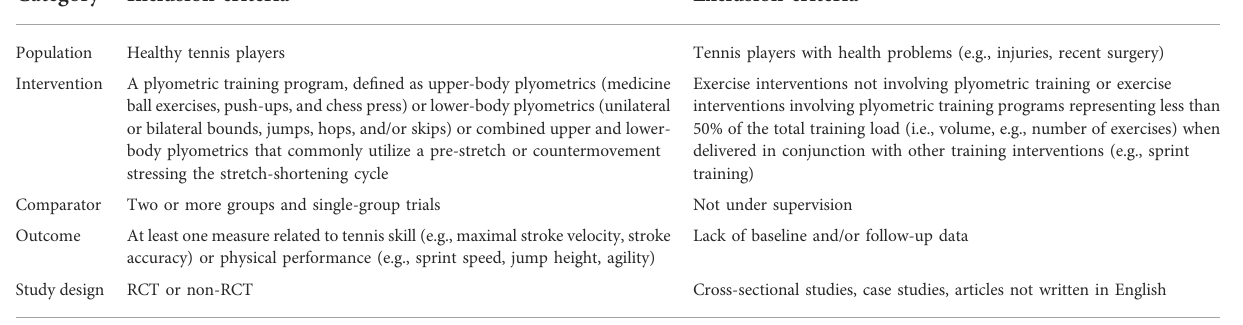
TABLE 1 Eligibility criteria according to the PICOS